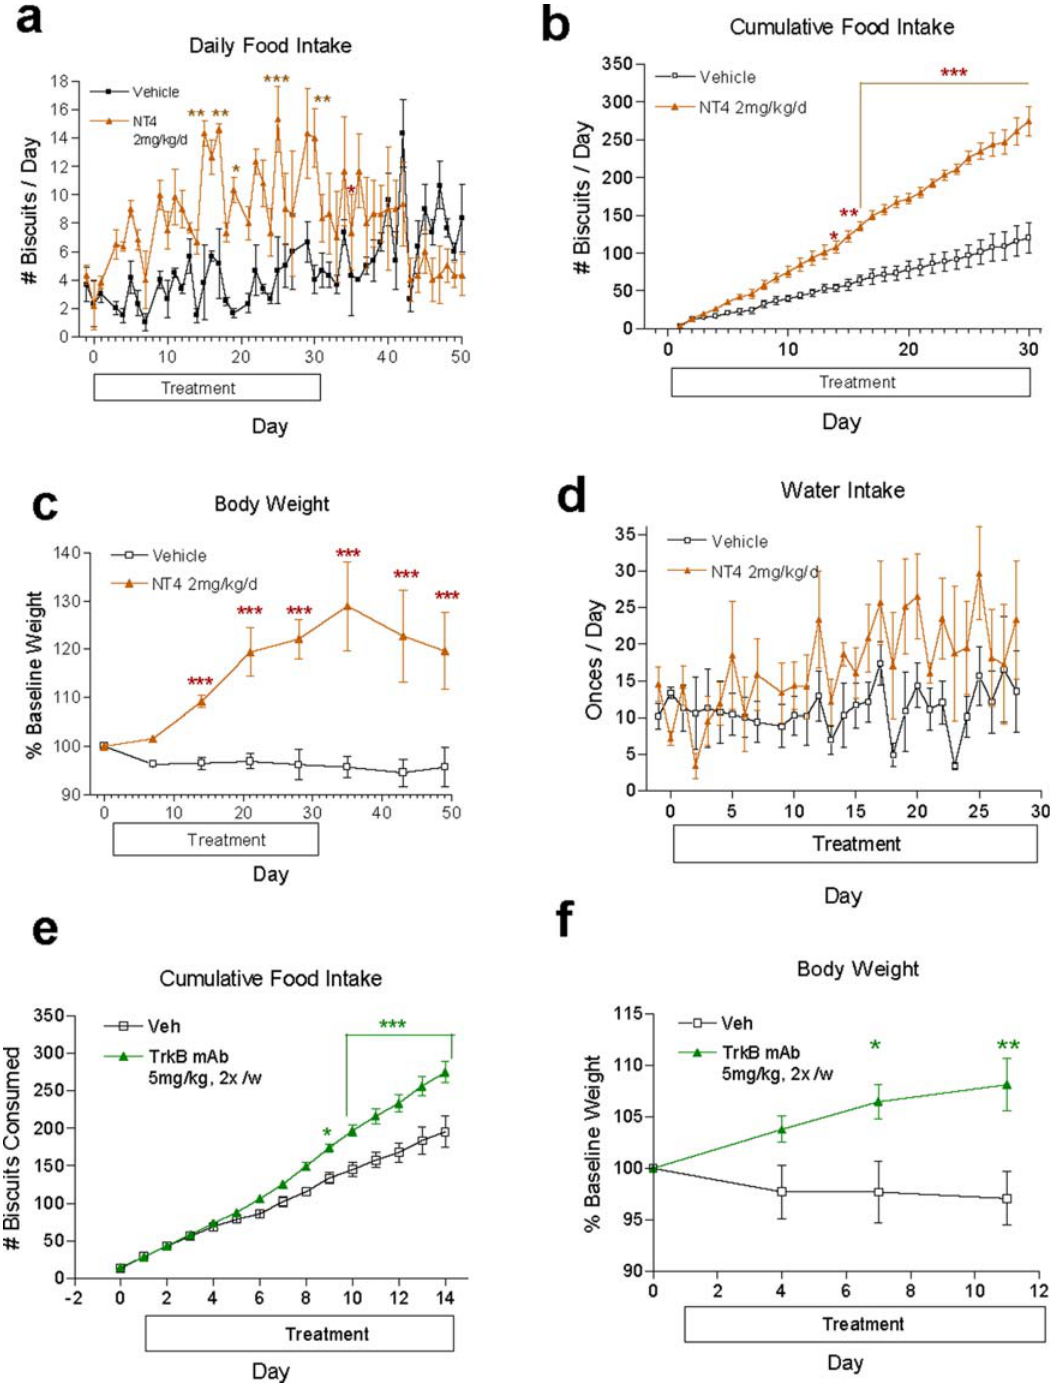
Figure 3. Peripheral application of TrkB agonists leads to gain in appetite, fat deposits and weight in lean Cynomolgus monkeys. a– d , Daily treatment of non-obese, adult females, Cynomolgus (baseline body weight 3–5 kg) with 2 mg/kg/day NT4 IV (n=3 per group) for 30 days led to a significant increase in daily food intake (a) , cumulative food intake (b) and body weight (c) without significant change in water intake (d) . e– f , Lean, adult female Cynomolgus monkeys (n=3 per group) that were treated twice a week with IV injections of 5 mg/kg of a TrkB agonist antibody exhibited a significant increase in cumulative food intake ( e ) and weight gain ( f )